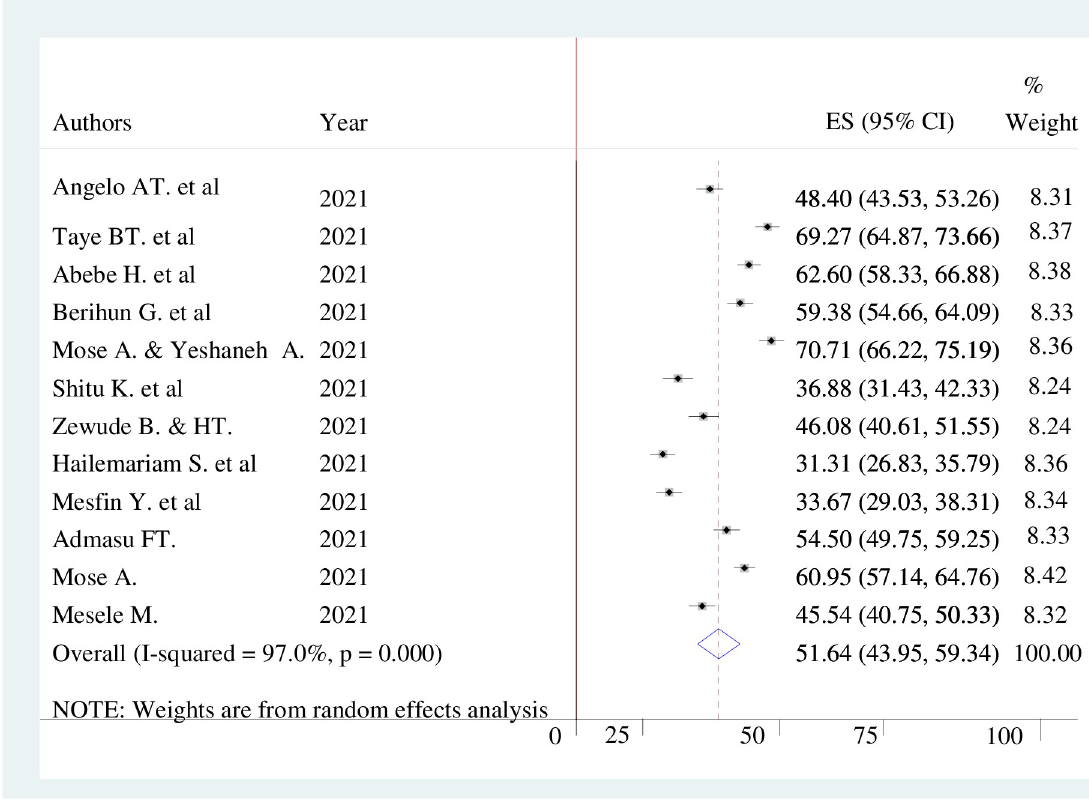
Fig 2. Pooled prevalence of COVID-19 vaccine acceptance in Ethiopia,